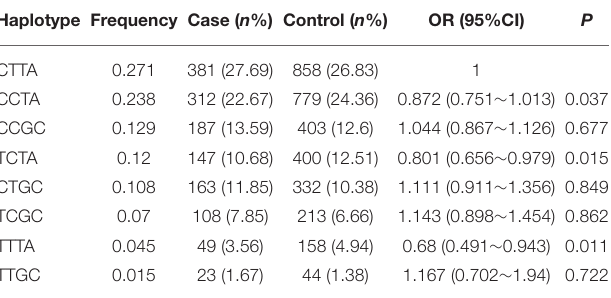
TABLE 5 | Frequencies of haplotypes (rs2297406-rs2472433-rs2472510-rs251 5614) among cases and controls and association with the risk of DBP. Haplotype Frequency Case ( n %) Control ( n